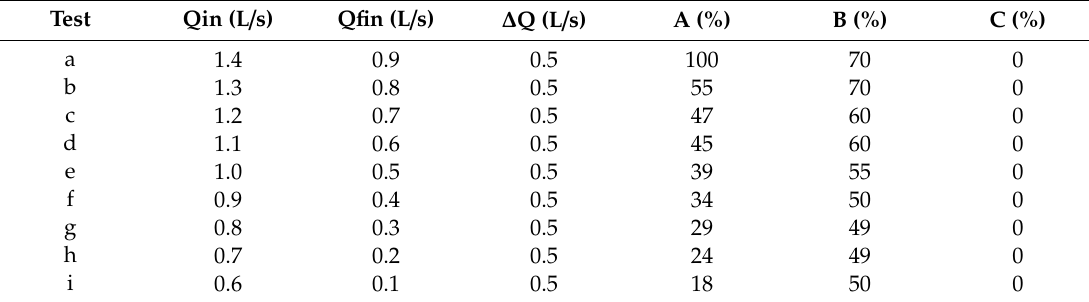
Table 1. Boundary conditions characterising the nine test configurations.